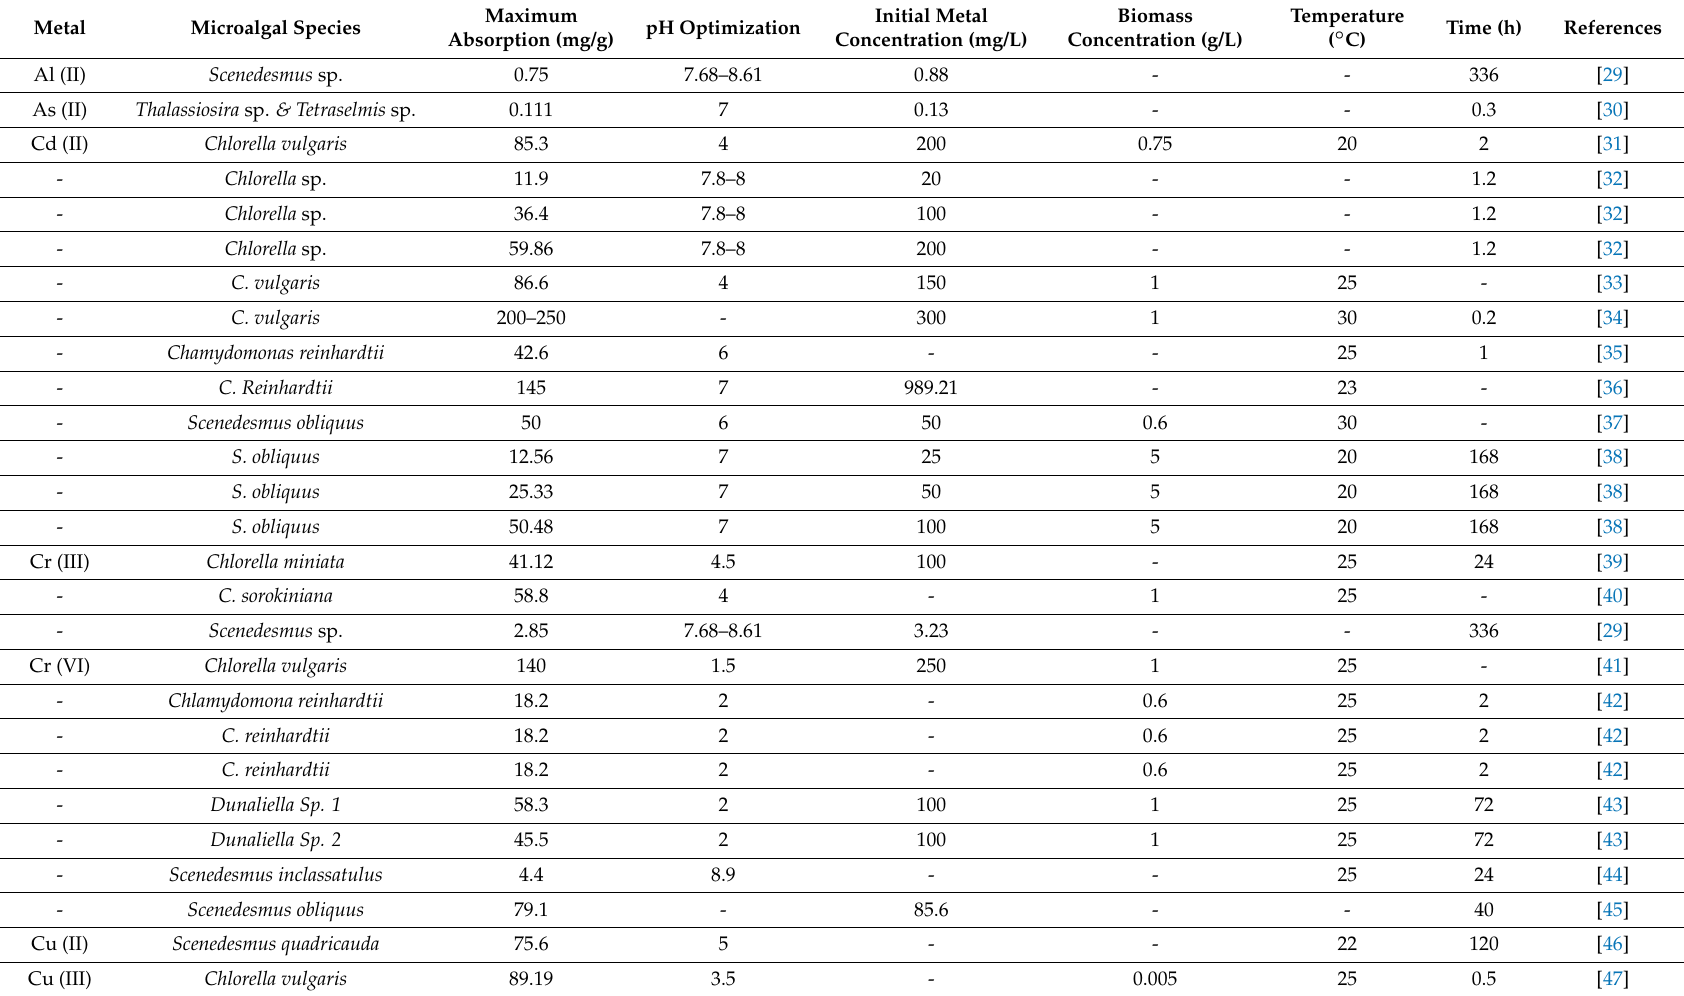
Table 3. Heavy metal absorption capacity from different microalgal species (Modified from